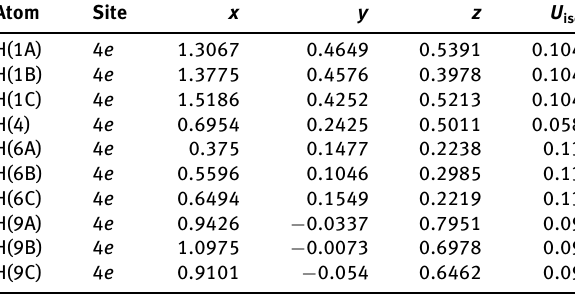
Table 2: Fractional atomic coordinates and isotropic or equivalent isotropic displacement parameters (Å 2